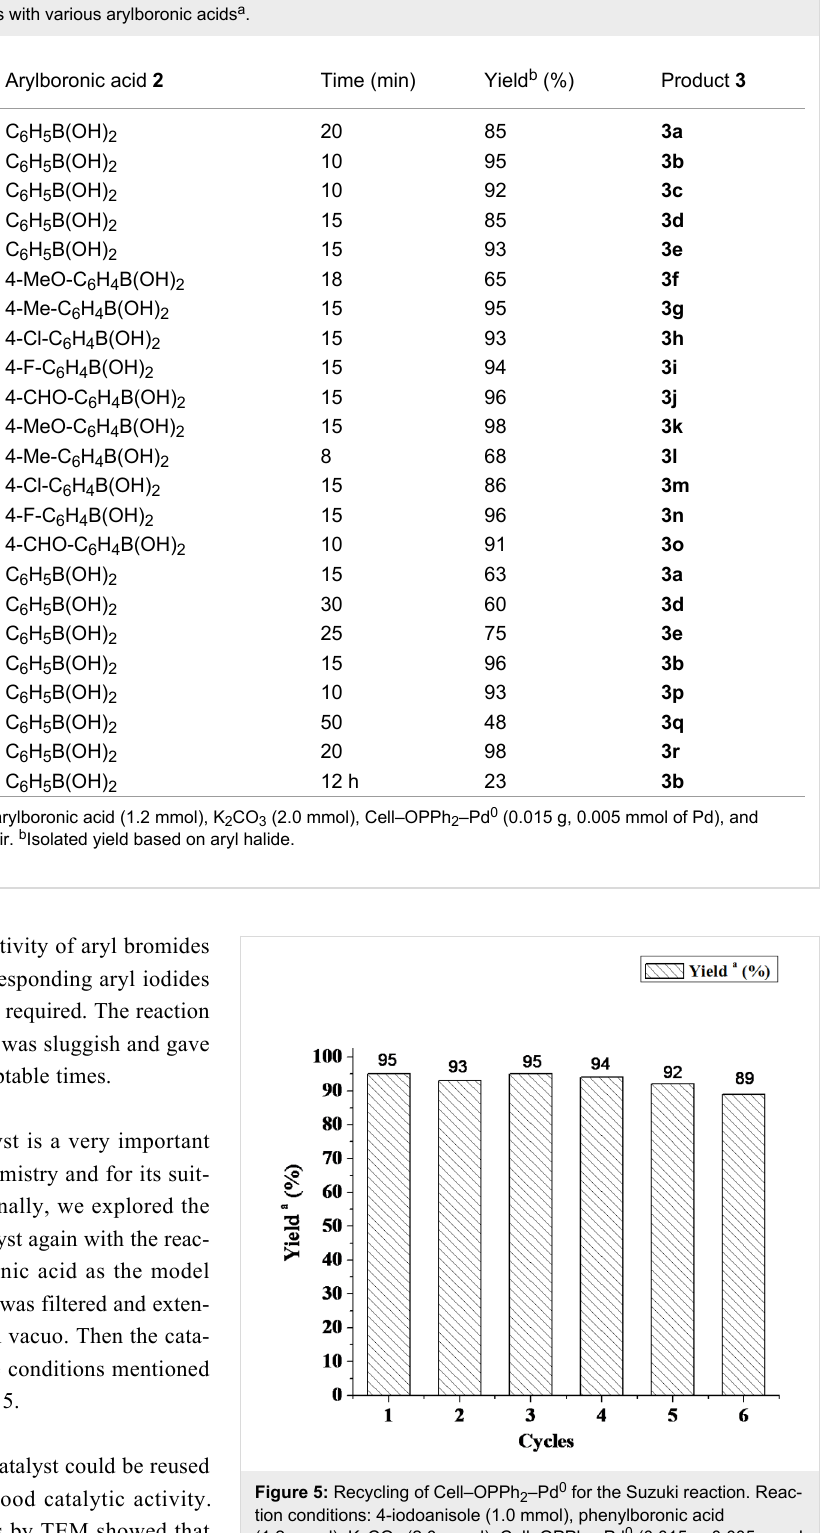
Table 4: The coupling reactions of aryl halides with various arylboronic acids a .